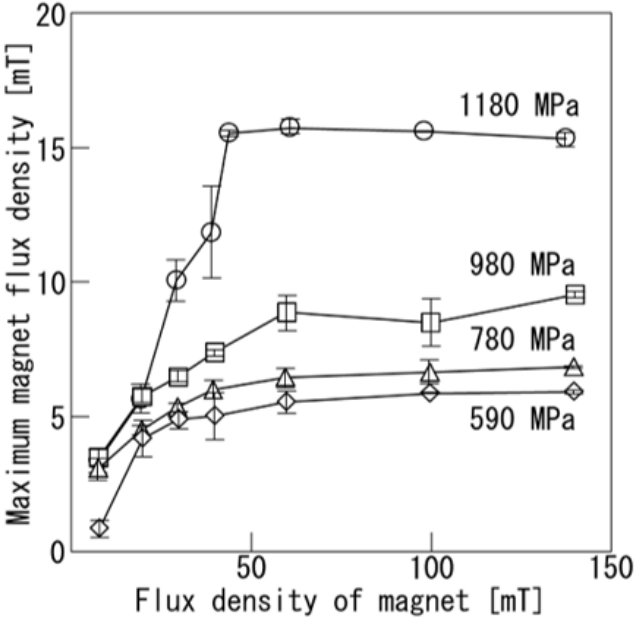
Figure 6. Relationship of maximum magnetic flux density of the sheets and magnetic flux density of magnet used for magnetization.